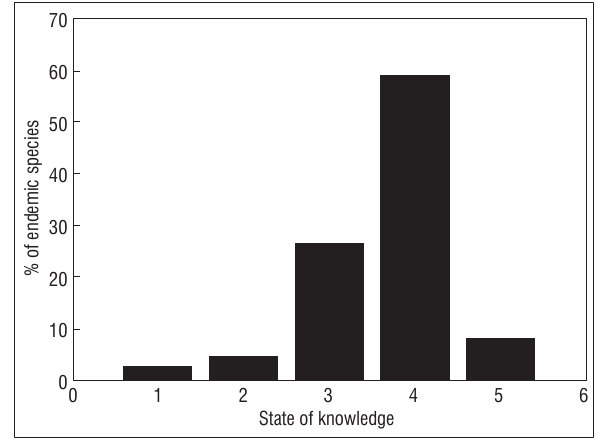
Figure 1: The proportions of endemic species in various taxonomic groups relative to their states of taxonomic knowledge as rated from poor (1) to excellent (5).